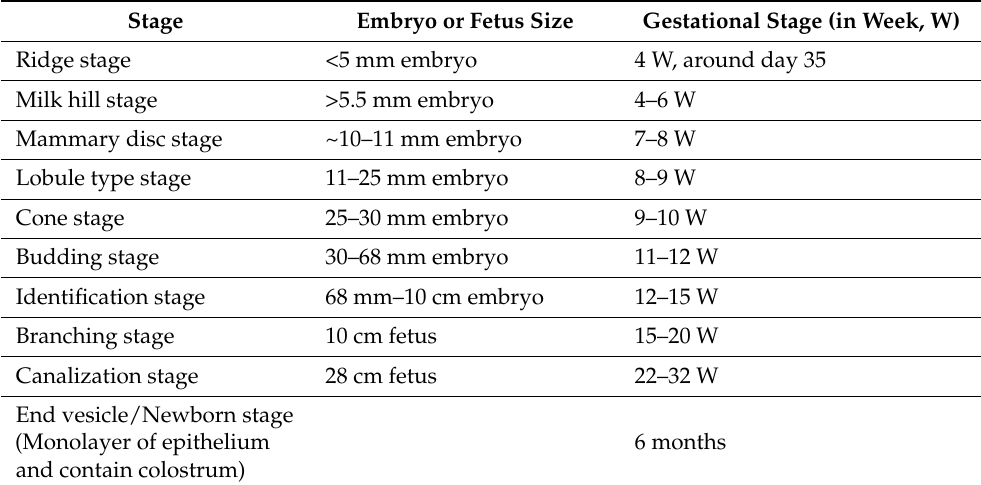
Table 1. Classification of human embryonic mammary gland development